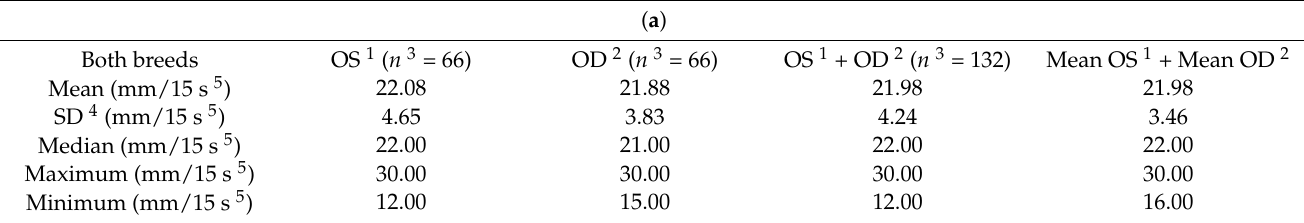
Table 1. ( a ) Descriptive and inferential statistics of PRTT data in both breeds; ( b ) descriptive and inferential statistics of PRTT data in the Livorno breed; ( c ) descriptive and inferential statistics of PRTT data in the Siciliana breed. ( a ) Both